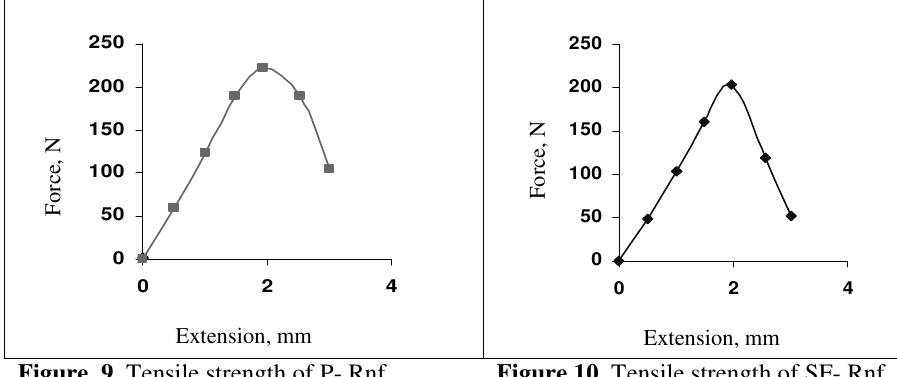
Figure .9. Tensile strength of P- Rnf composite